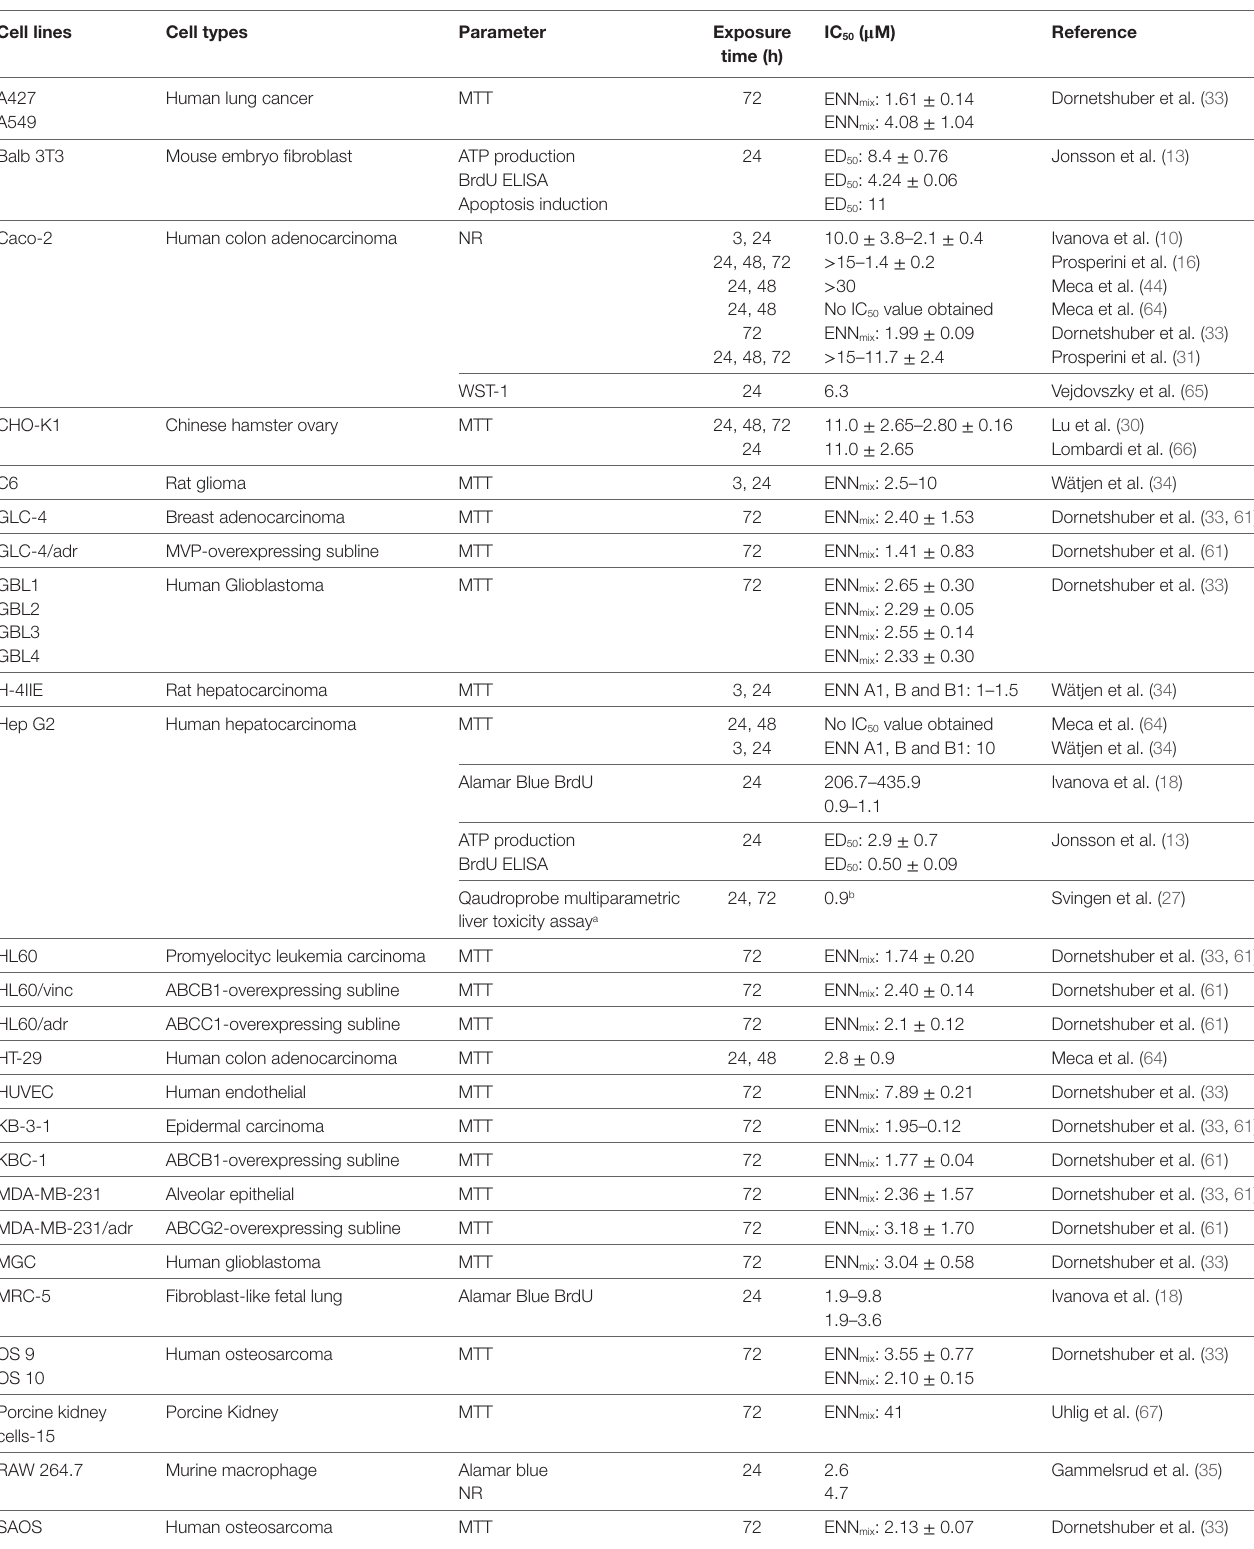
TABLe 2 | In vitro cytotoxicity studies on enniatin B determined by different toxicity endpoint, time of exposure and cell types. Cell